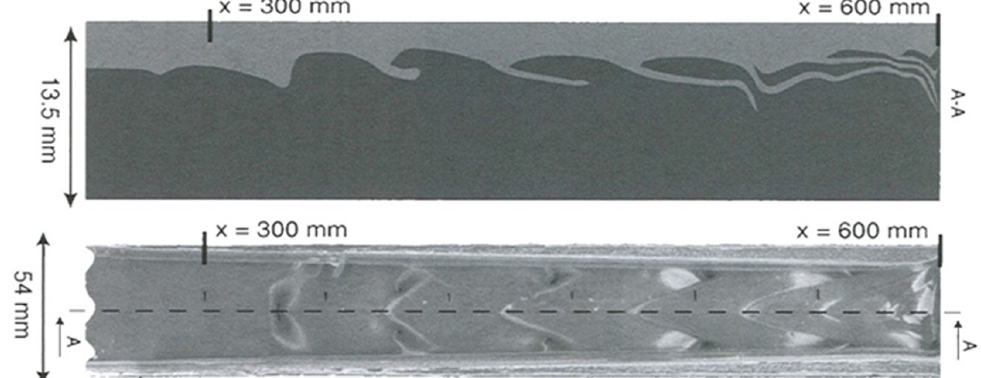
Figure 18. Coextrusion of a polyethylene ( bottom ) and a polystyrene ( top ). View of the second half of the extracted sample. Bottom photo: top view; upper photo: side view. The flow was from left to right (Reprinted from Ref. [28]).